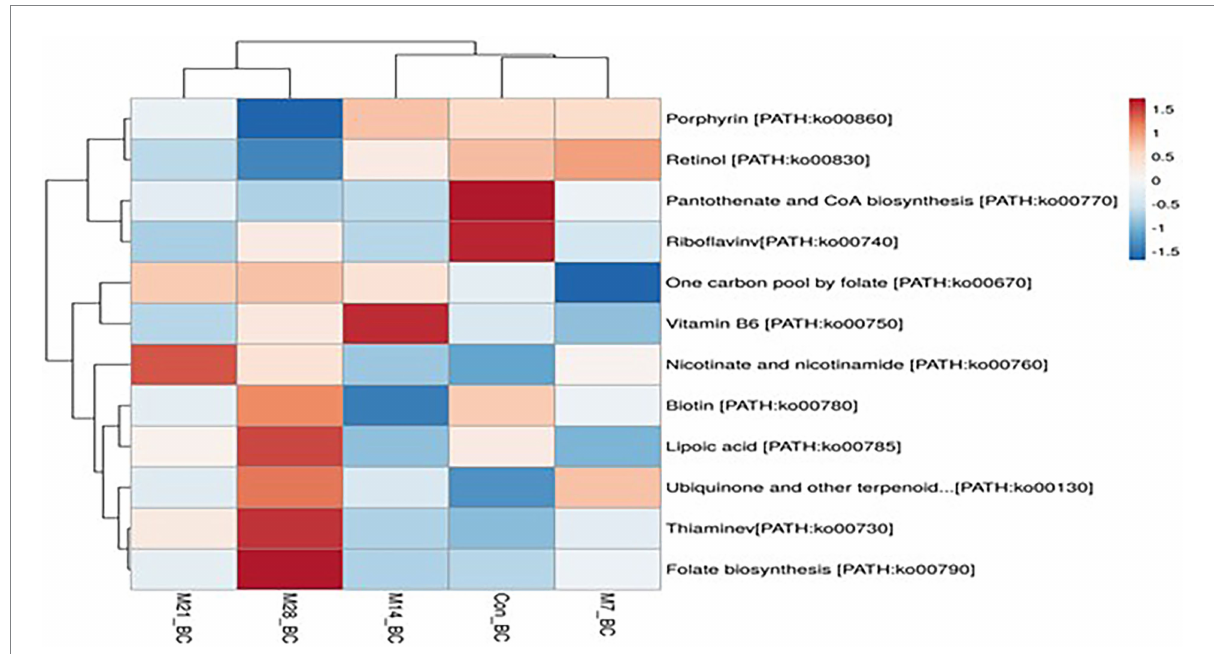
FIGURE 6 The heatmap showing relative abundance of pathways involved in Cofactors and vitamins metabolism in the caecum digesta samples from broiler chickens fed with diets containing different levels of marama bean meal. The X -axis shows the treatment groups [Treatment groups: 0% (Con_BC); 7% (M7_BC); 14% (M14_BC); 21% (M21_BC); 28% (M28_BC) inclusion levels] while Y -axis represents metabolism pathways. The scale bar shows the colour saturation gradient dependent on the relative abundance of the microbial pathways. The colour intensity in each panel reflects relative abundances used for analysis (blue: low, white: medium, red: